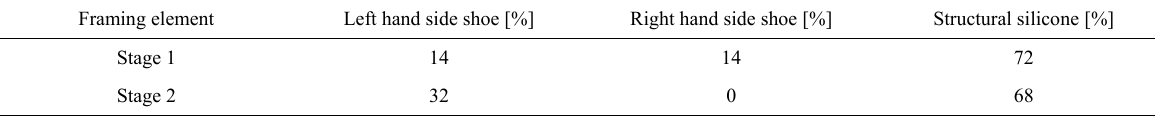
Table 4: Dead load distribution.